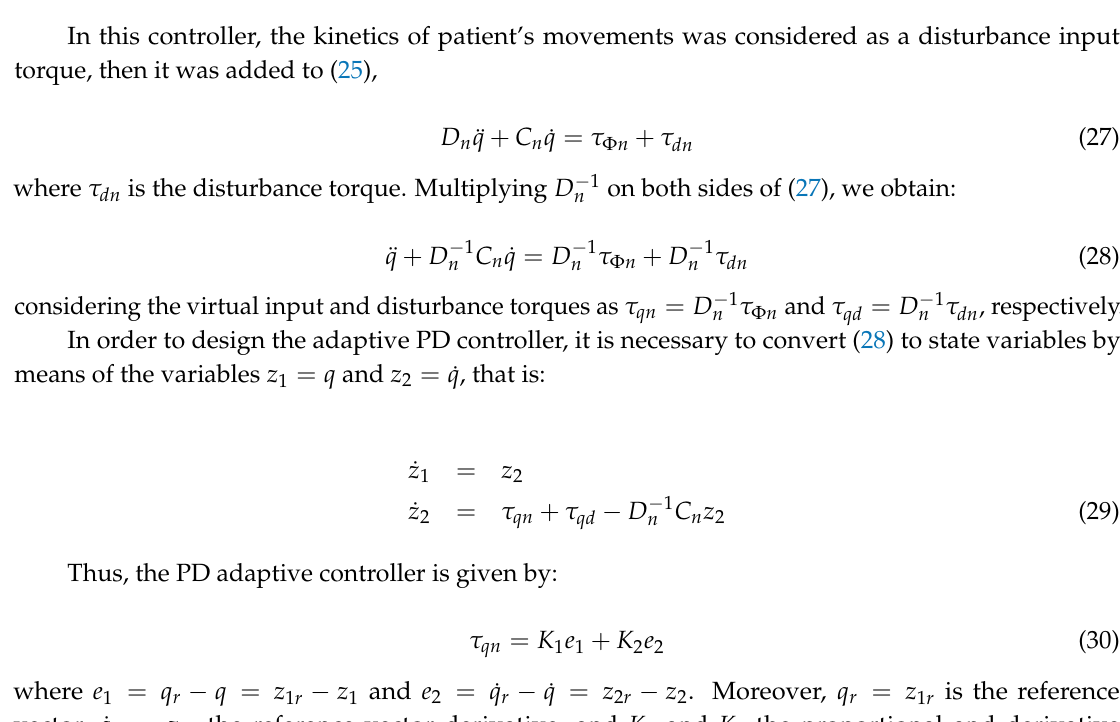
Figure 9. Control concept, adaptive